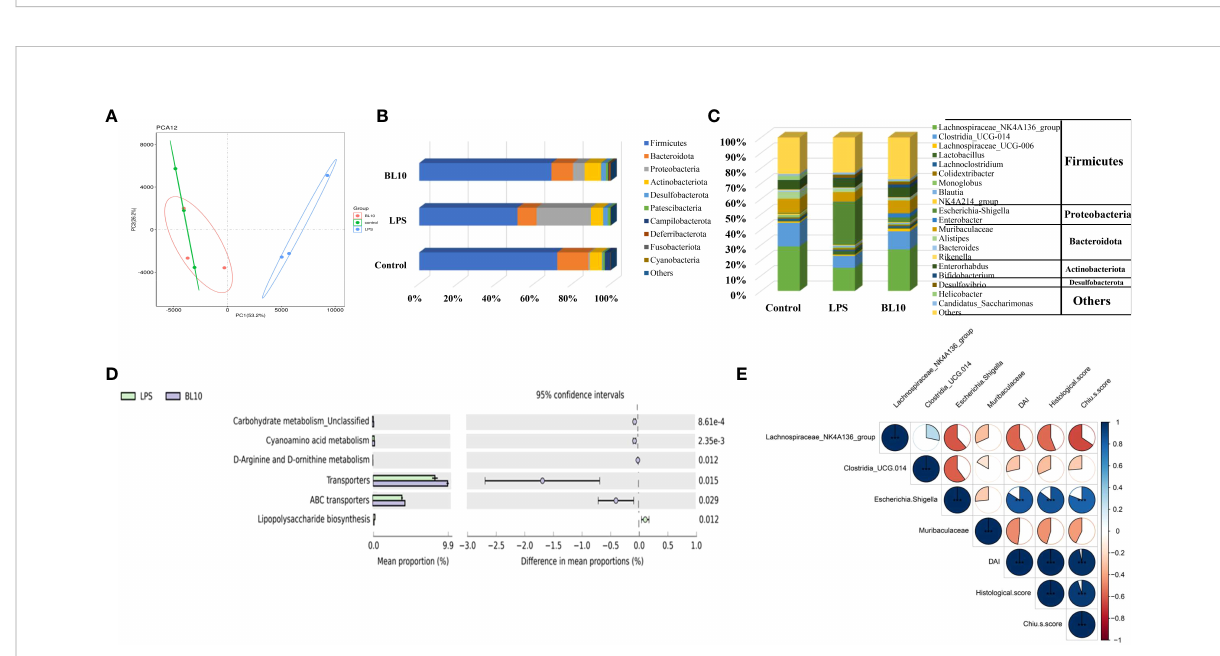
FIGURE 8 Effect of B longum BL-10 on NF- k B signaling pathway and immune key protein. (A) NF- k B signaling pathway; (B) Immune key protein. All data are expressed as mean ± SD (n=3). Values with a different superscript letter (*, **, ***, **** and ns) were signi fi cantly different at p <0.05, p <0.01, p <0.001, p <0.0001 and p